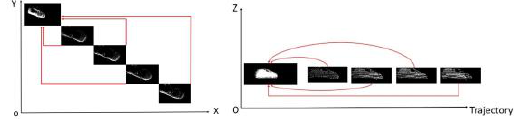
Figure 7. Model construction from plan and side views.